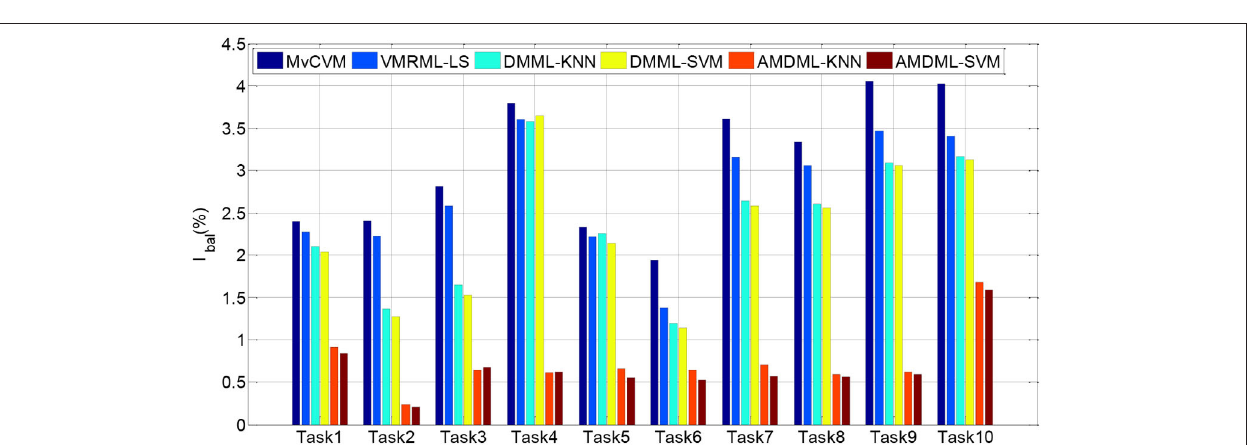
FIGURE 2 | Classification accuracies of six methods on 10 EEG classification tasks.